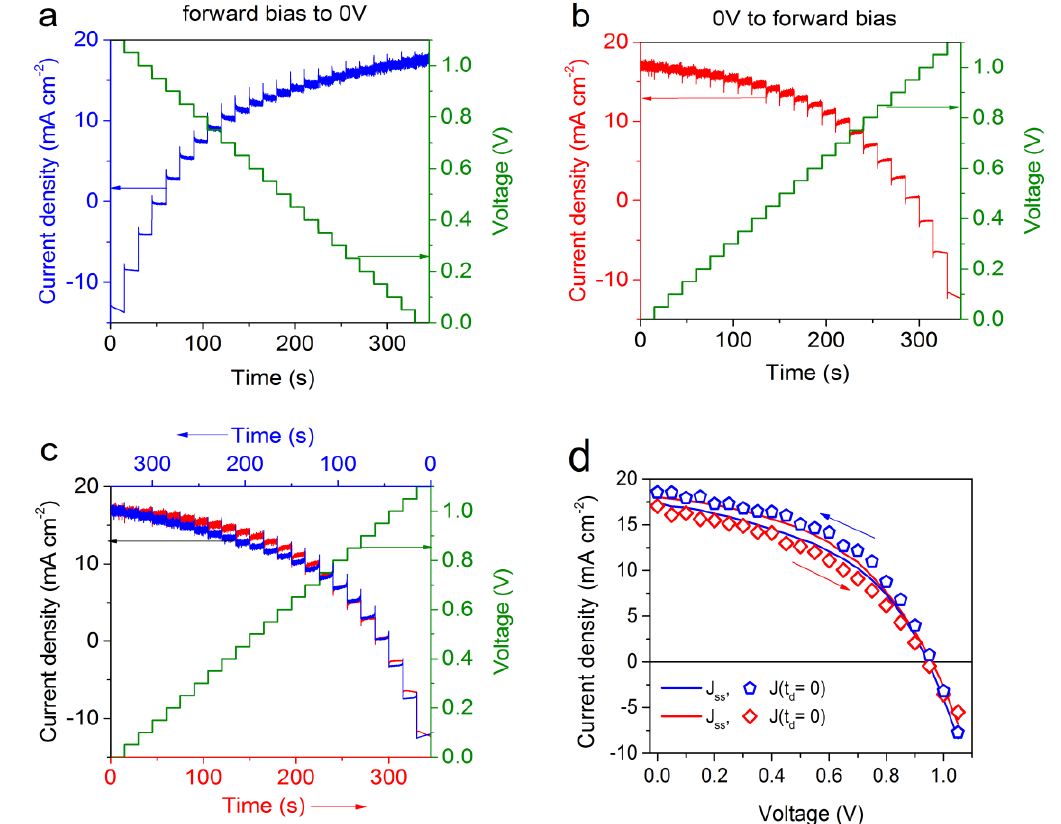
Figure 2. I , V ( t ) scan in the reverse scan direction ( a ) exhibits an over-shoot followed by a transient decay while in the forward scan direction ( b ) the photocurrent drops followed by an exponential increase during each potential step. The overlay of both data set in ( c ) was created by reversing the time axis for the forward scan. Plot ( d ) shows the resulting I ( V ) curves derived from the I , V ( t ) plots (a–c) using either the steady-state current density, J ss , or the current density at negligible delay time J ( t d = 0 ) for the current